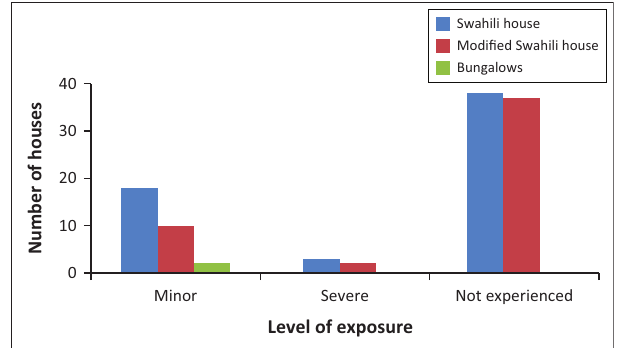
FIGURE 7: House types relationship with fire exposure.